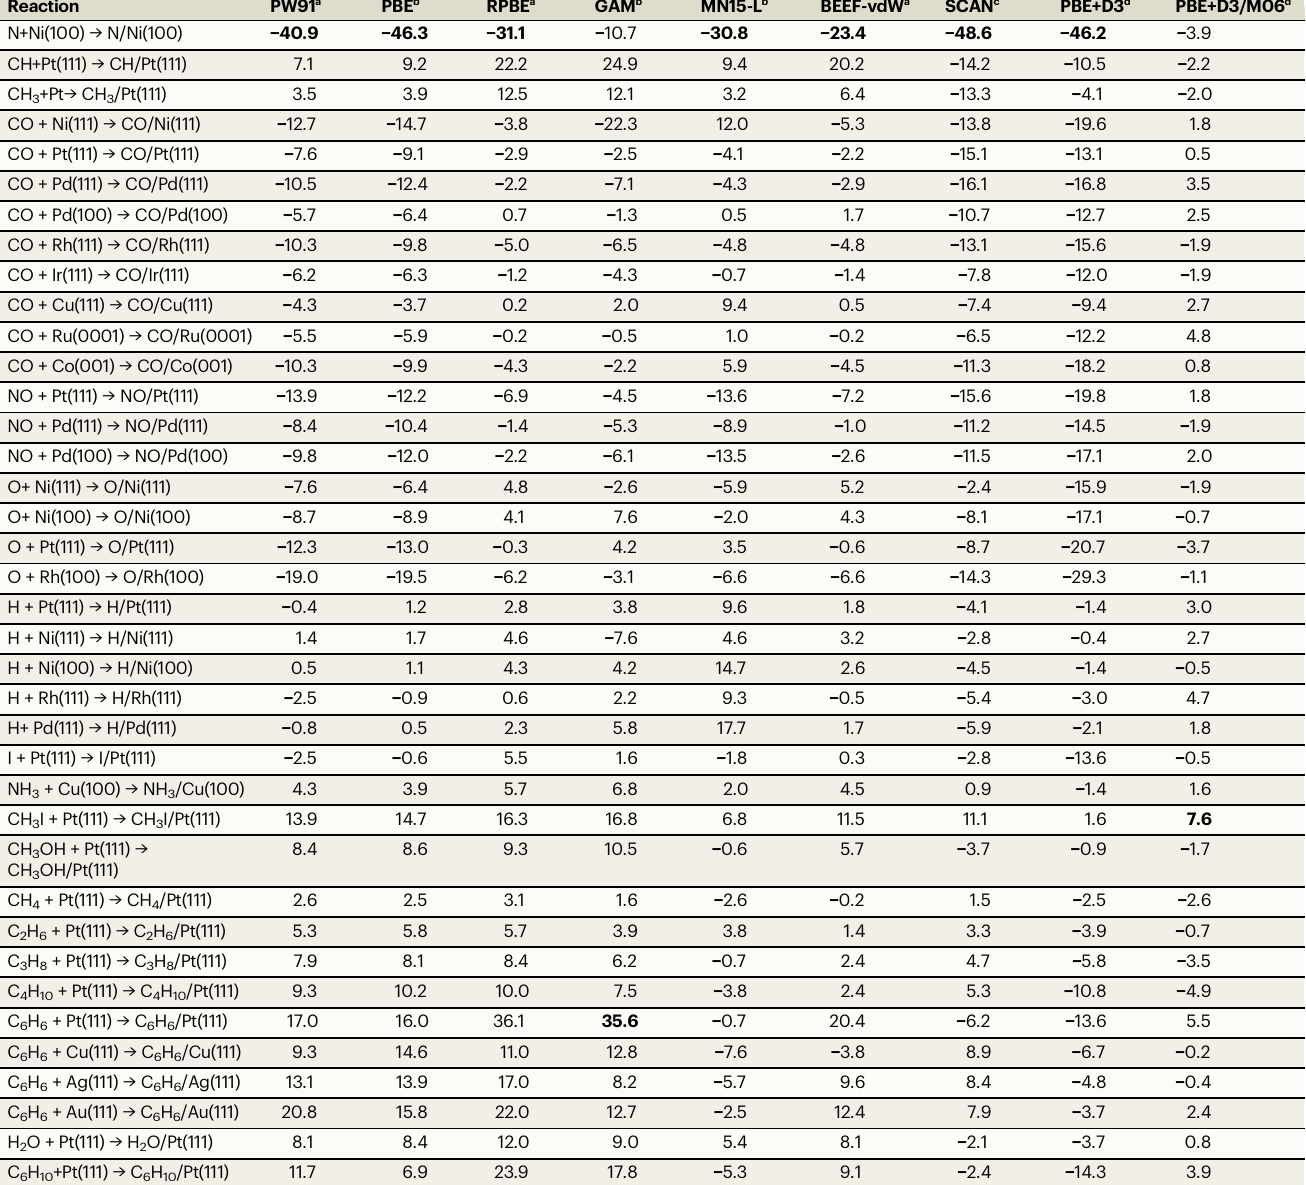
Table 2 | Difference (theory − experiment) between the reference adsorption energies [kcalmol − 1 ] and the values obtained with PW91, PBE, RPBE, GAM, MN15-L, BEEF-vdW, SCAN, PBE+D3 and PBE+D3/M06